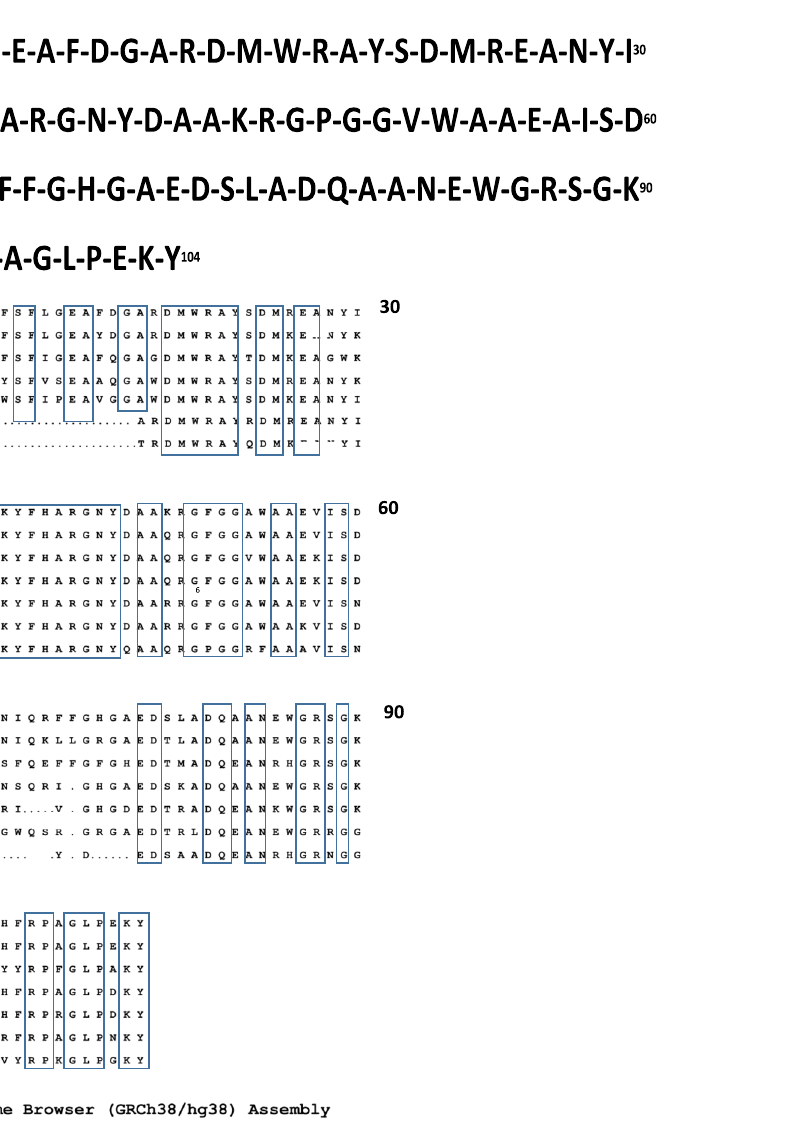
SAA sequences in different organisms. Conserved residues noted in boxes. (USCS Genome Browser [GRCh38/hg38]